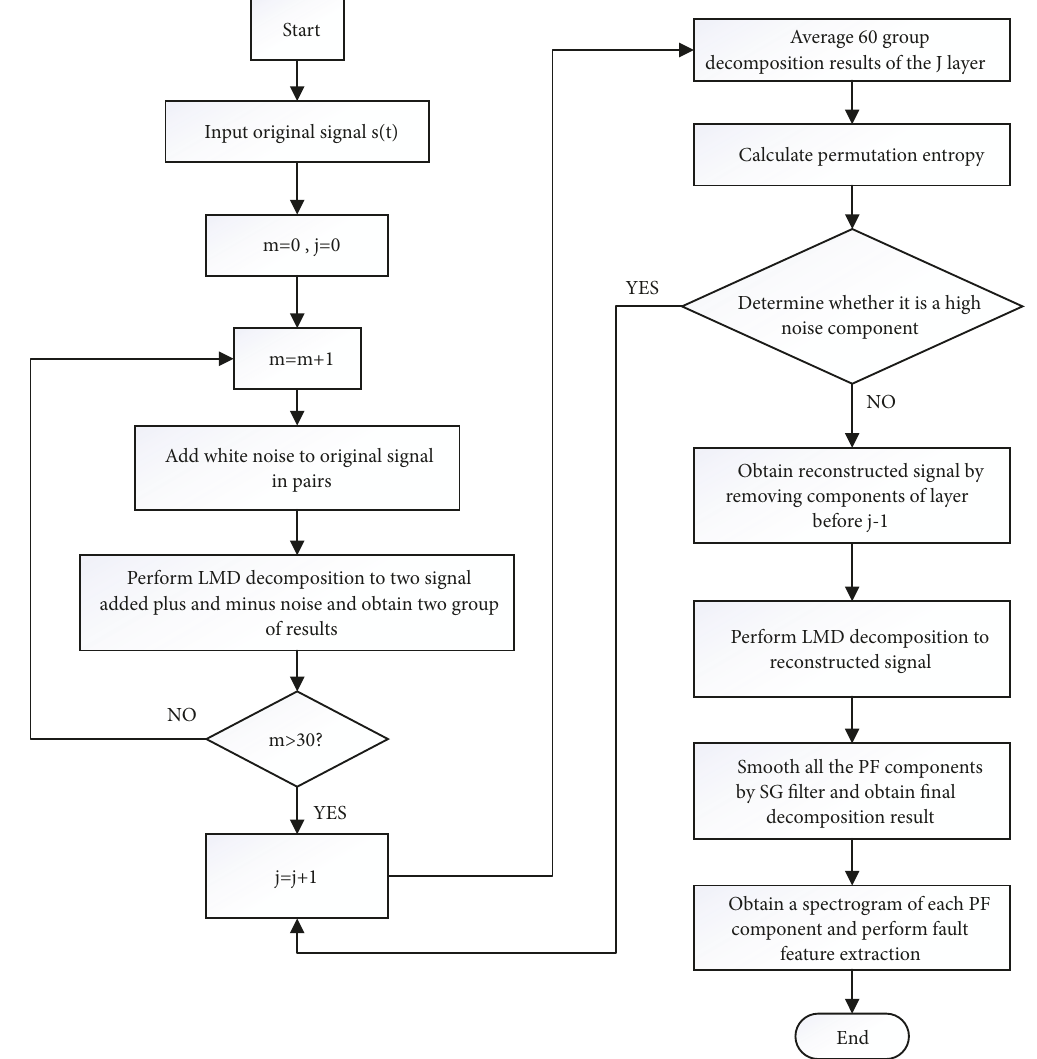
Figure 3: Improved ELMD method flow